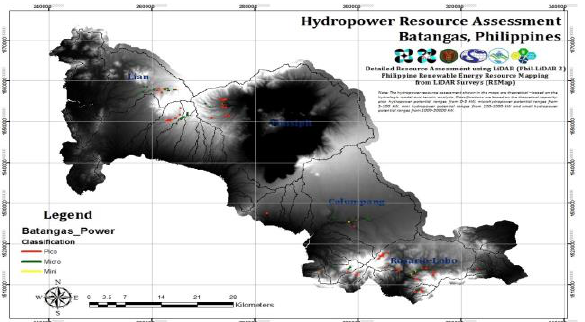
Figure 1. Sample hydropower assessment map